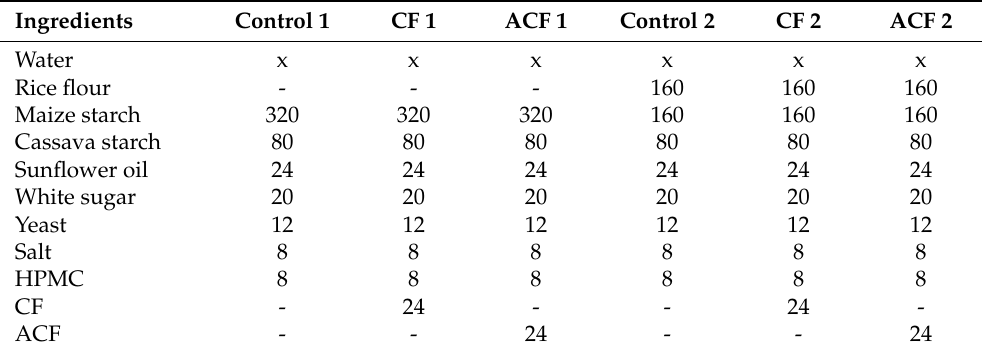
Table 1. Formulation (in grams) of bread samples prior to the determination of their optimum moisture